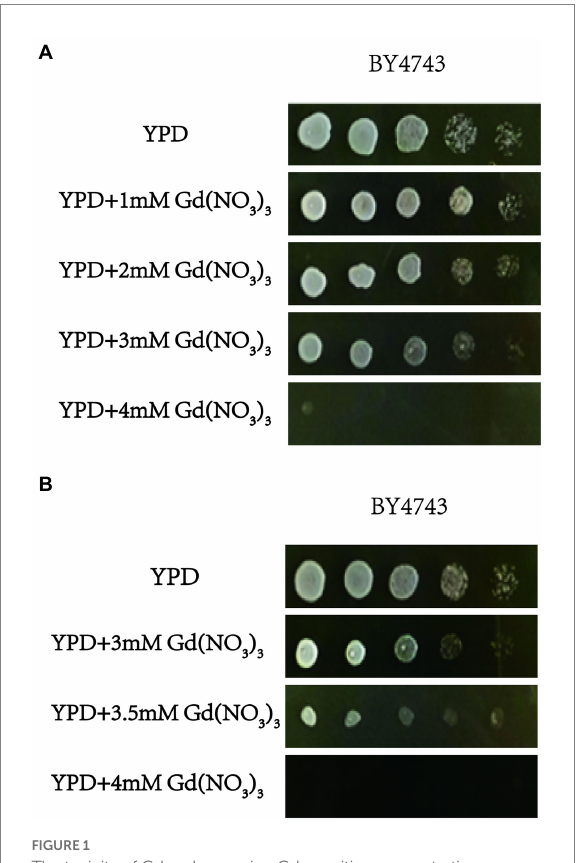
FIGURE 1 The toxicity of Gd and screening Gd-sensitive concentration. (A) Effect of 0, 1, 2, 3, and 4 mM Gd on yeast growth. (B) Effect of 3, 3.5, and 4 mM Gd on yeast growth. To find a sublethal concentration of Gd to S. cerevisiae , the effect of 0, 1, 2, 3, and 4 mM Gd on the yeast growth was observed, and 4 mM Gd was lethal for yeast. For 4 mM Gd was lethal for yeast, three additional Gd concentrations (3, 3.5, and 4 mM Gd) were further used to study the effect of Gd on yeast growth. The experiment was repeated three